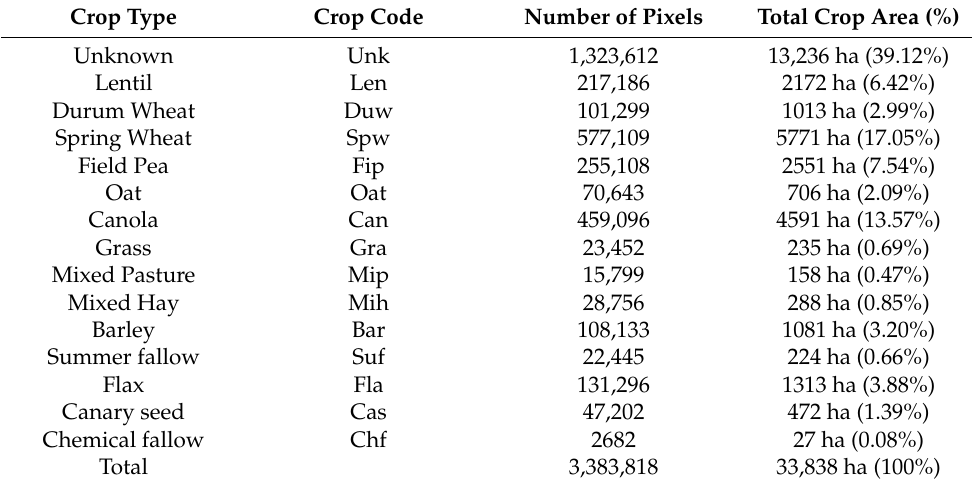
Table 3. Crop type and area statistics of study